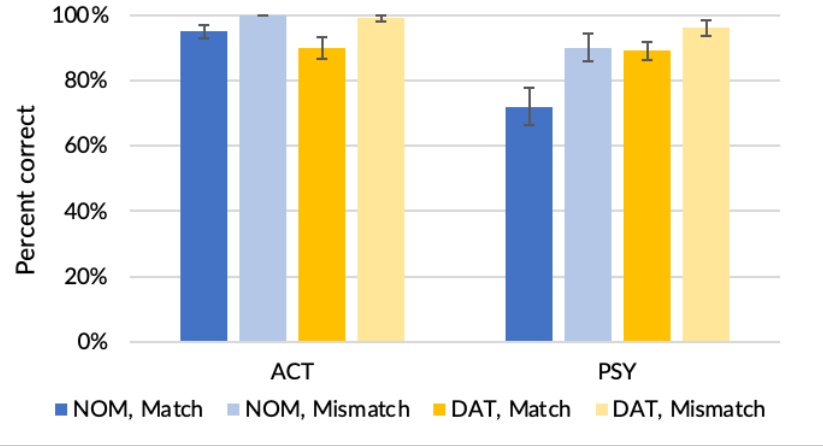
Figure 5. Results from adult group by verb type, extraction site, and number